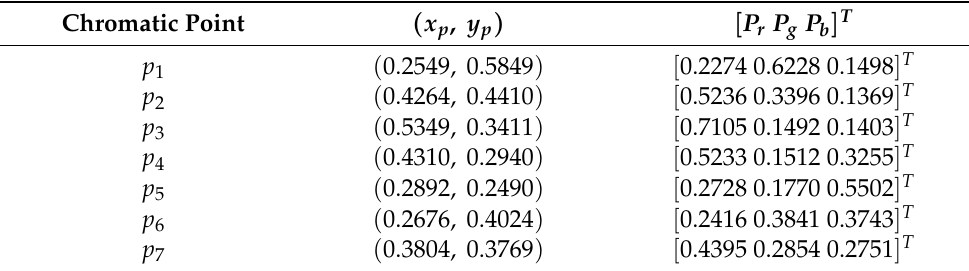
Table 1. Color coordinates and normalized optical power vector. Chromatic